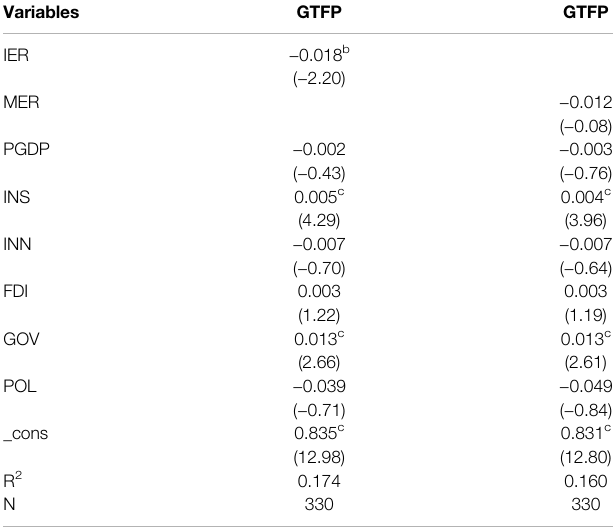
TABLE 2 | Regression results of the effect of environmental regulations on GTFP.